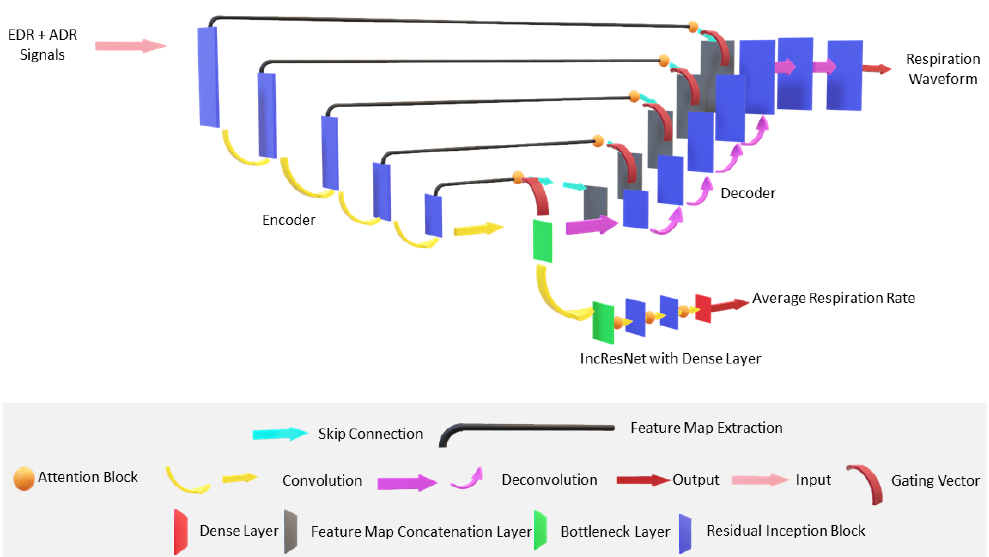
Figure 2. Proposed model architecture. The architecture is divided into three parts, namely, encoder, decoder, and IncResNet with dense layer. Other functionalities are embedded in the same